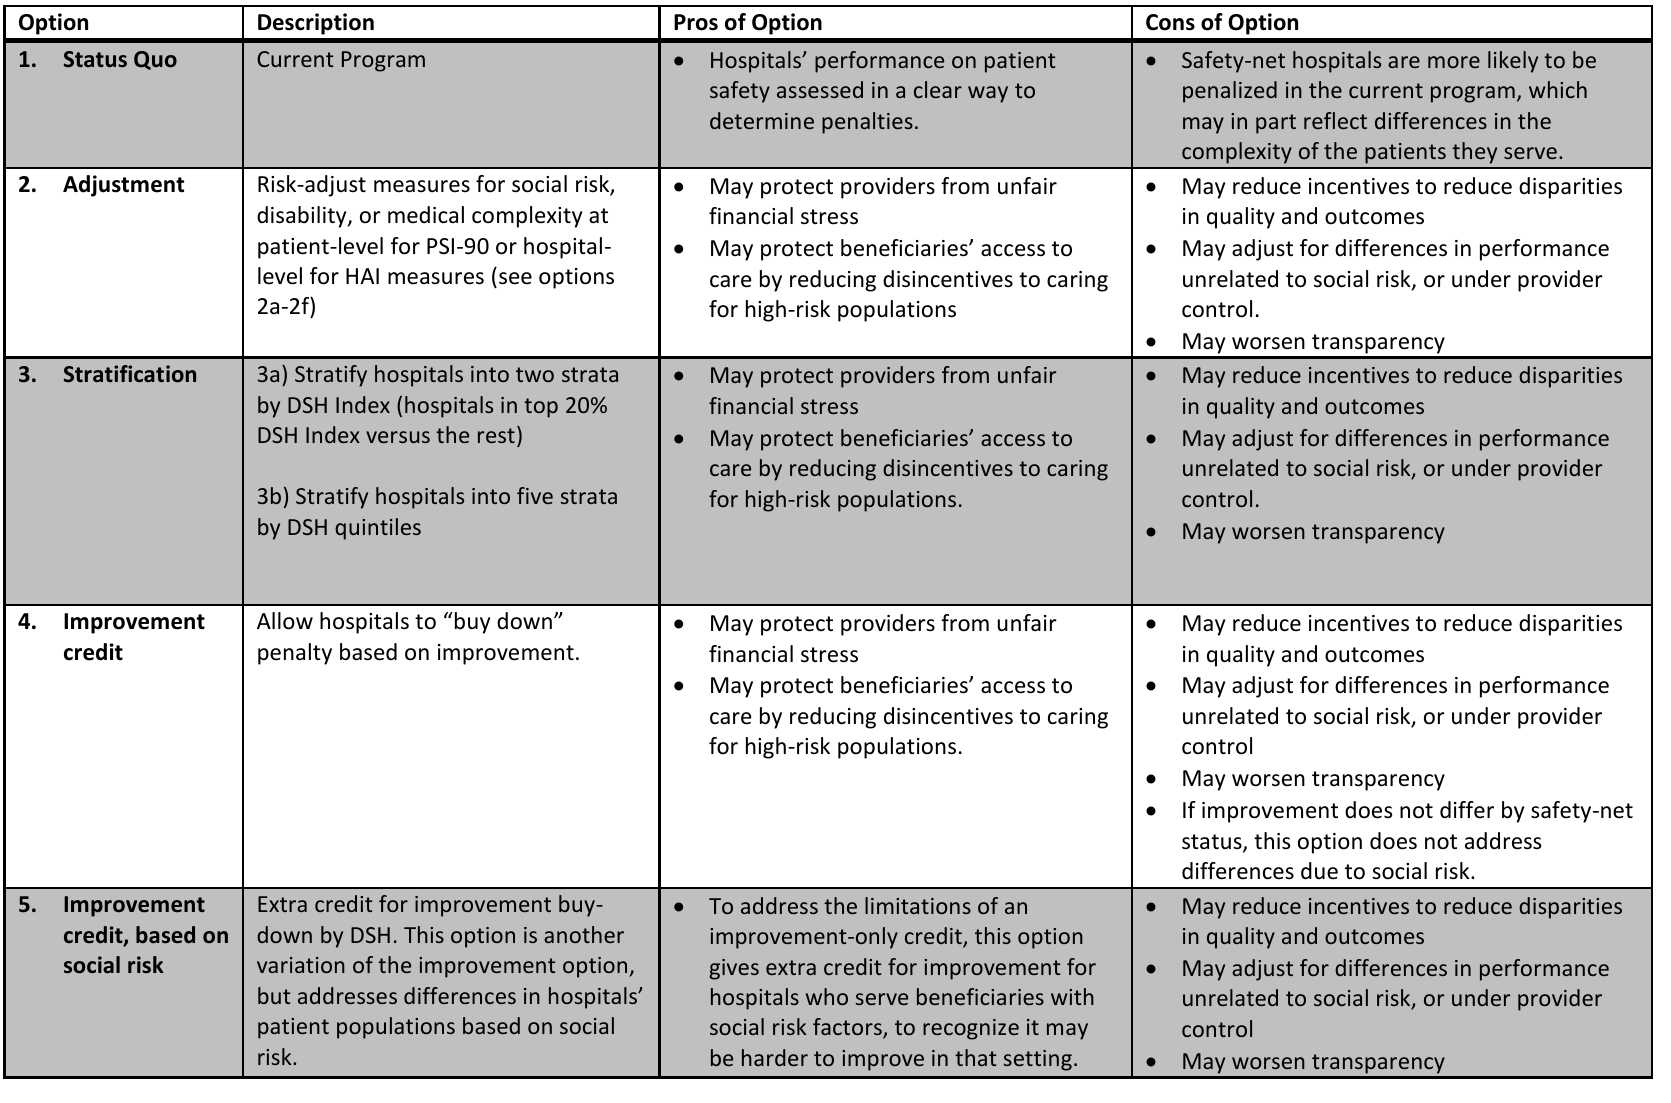
Table 6.12: Summary of Policy